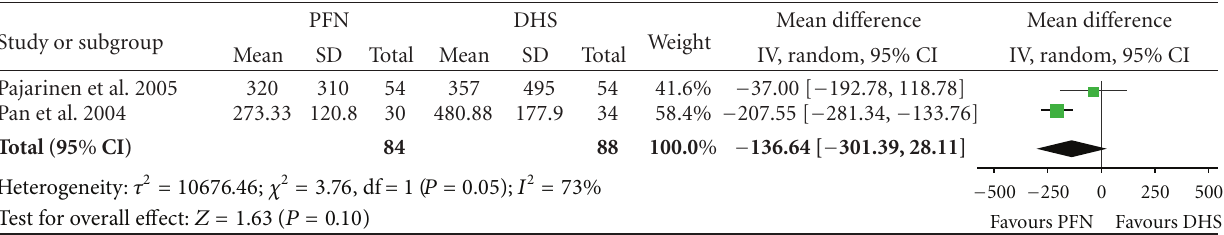
Figure 3: Comparison of blood loss between PFN and